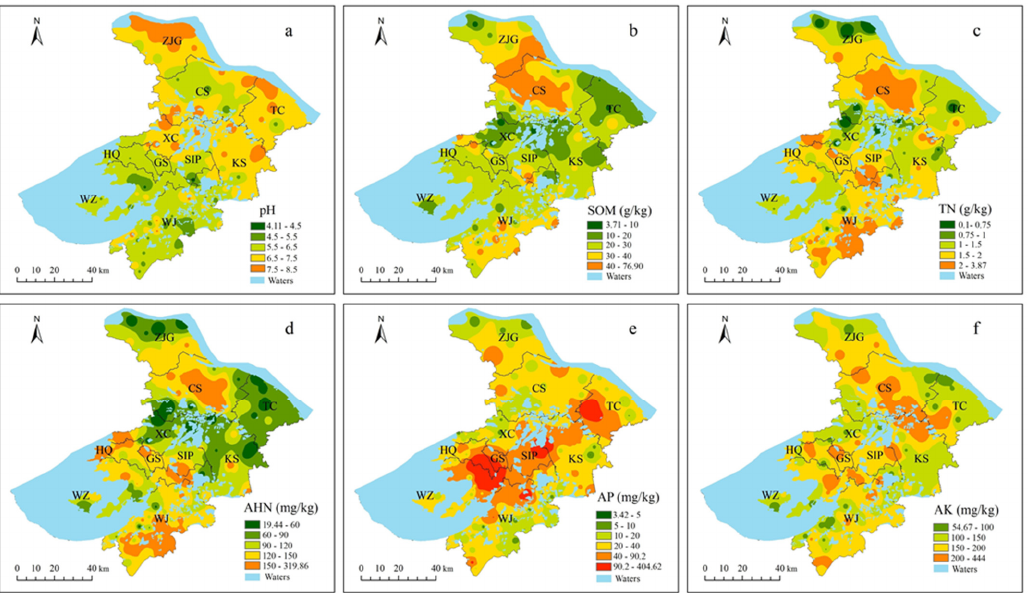
Figure 2. Spatial distribution of pH ( a ), SOM ( b ), TN ( c ), AHN ( d ), AP ( e ), and AK ( f ) contents in soils. The map was drawn according to soil pH and soil fertility indicator grading standards (Table 1).